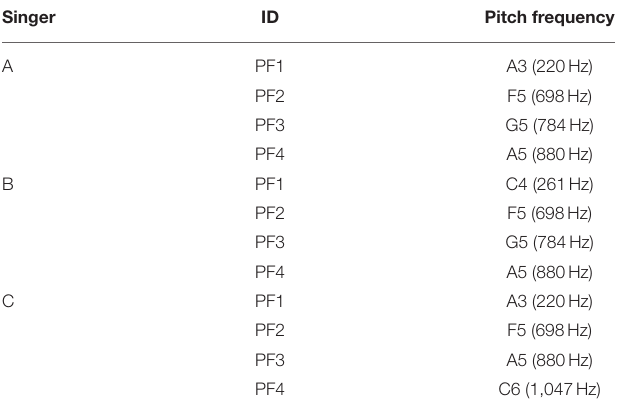
TABLE 2 | Pitch frequencies of participants’ singing voices.